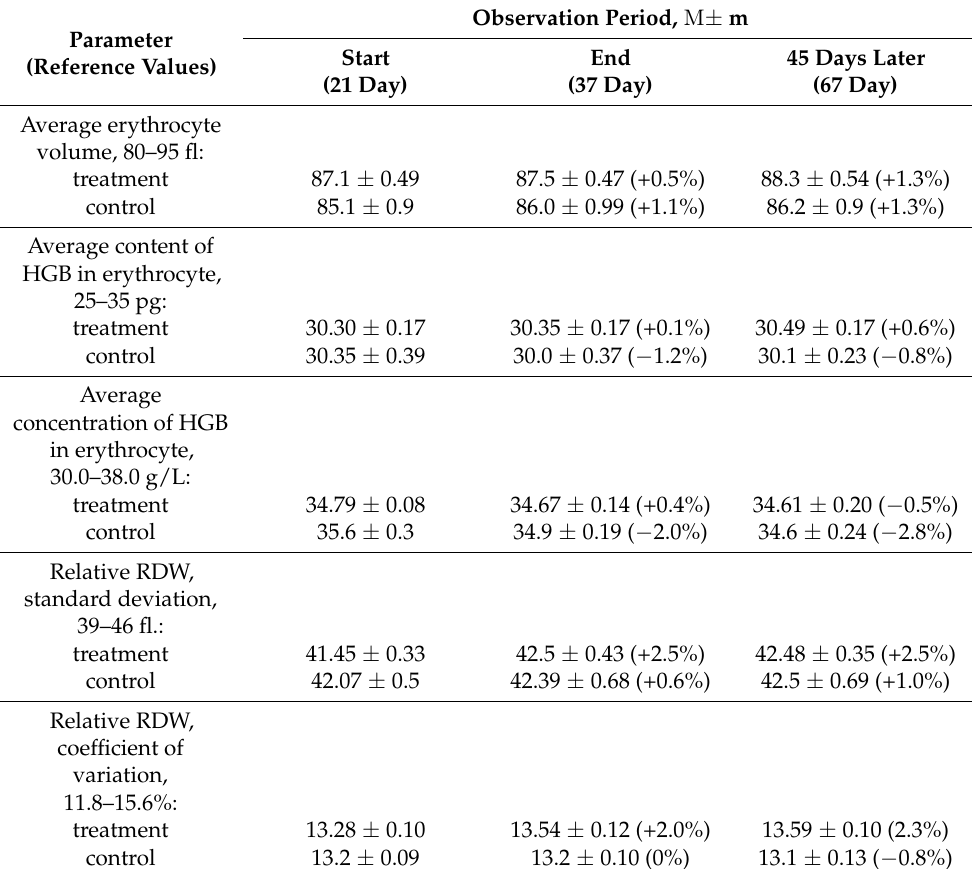
Table 6. Red blood cells during the period of food intervention (absolute